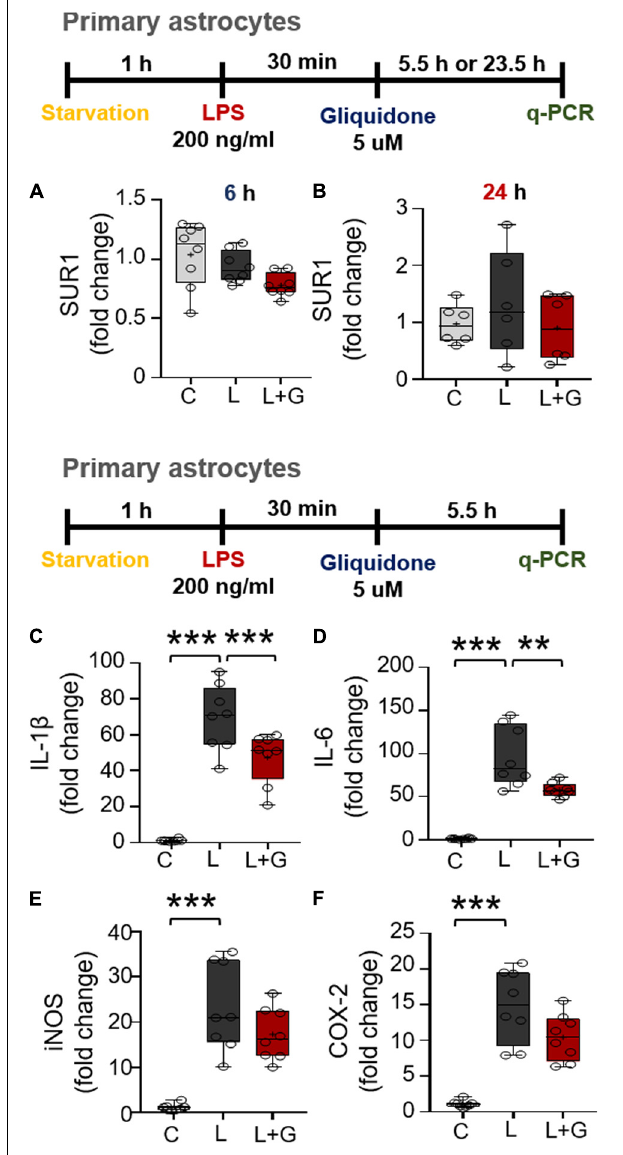
FIGURE 9 | Post-treatment with gliquidone reduces LPS-stimulated IL-1 β and IL-6 mRNA levels in primary astrocytes. (A,B) Real time-PCR (q-PCR) analysis of SUR1 mRNA levels in primary astrocytes treated sequentially with LPS and gliquidone as indicated (6 h, n = 8/group; 24 h, n = 6/group). (C–F) Real time-PCR (q-PCR) analysis of proinflammatory cytokine levels in primary astrocytes treated sequentially with LPS and gliquidone as indicated ( n = 8/group). ** p < 0.01, *** p <